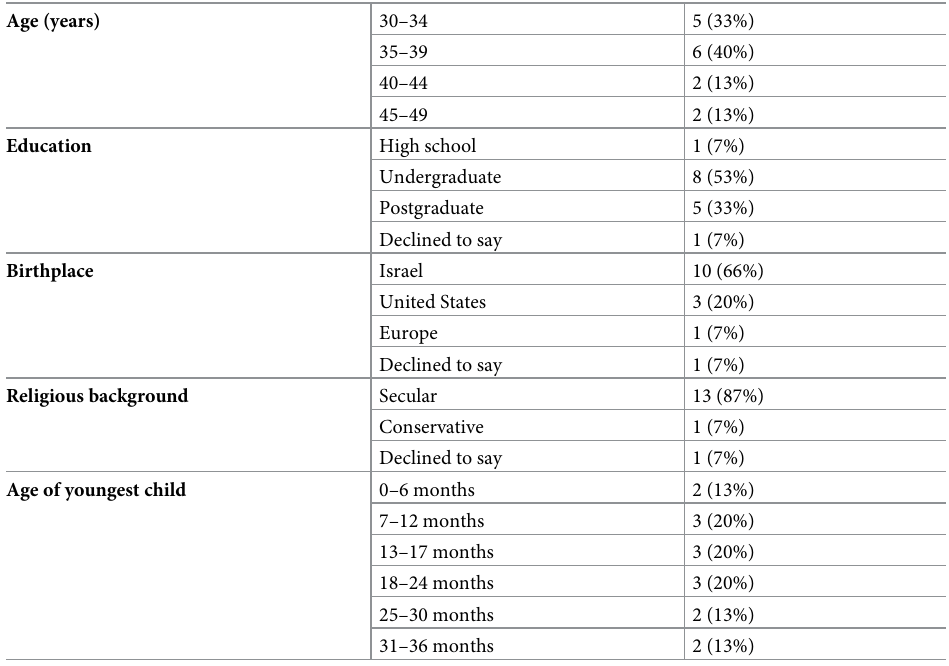
Table 1. Participant demographic